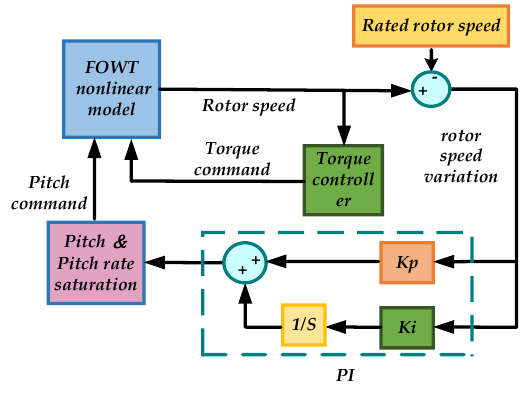
Figure 2. PI control scheme.